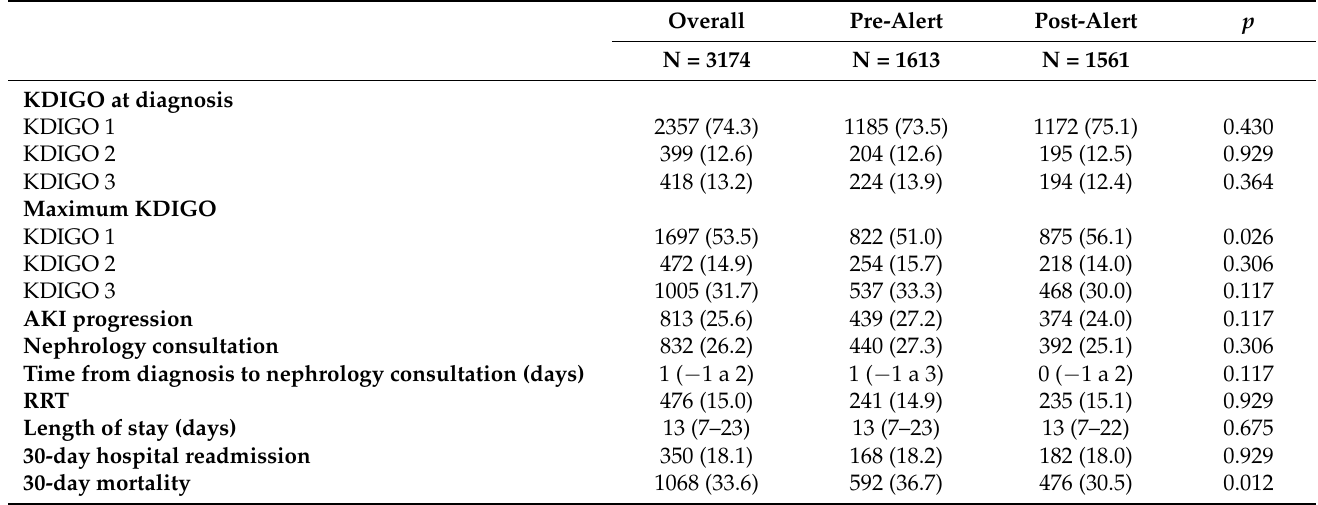
Table 2. Comparison of clinical outcomes between the pre-alert and post-alert